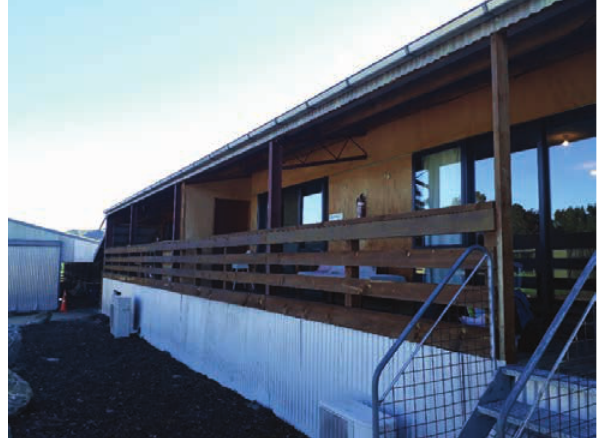
Figure 5: Waitaki woolshed conversion (front view) – from sheep shearing building to tourist accommodation, Waitaki District, South Island, New Zealand. Image provided by Author (Mike Mackay)